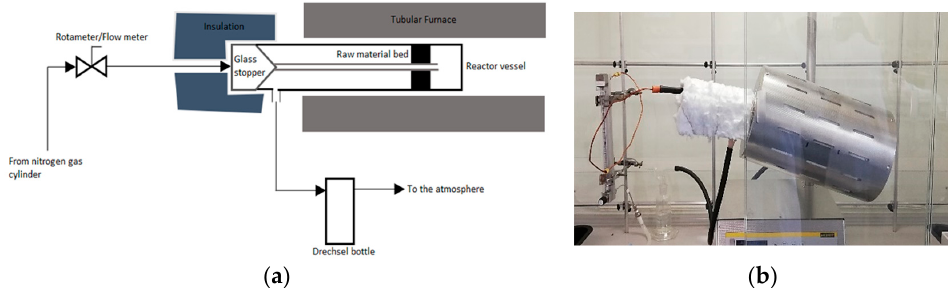
Figure 2. Experimental set-up for carbon-based materials synthesis ( a ) and electric tubular furnace containing the quartz vessel ( b